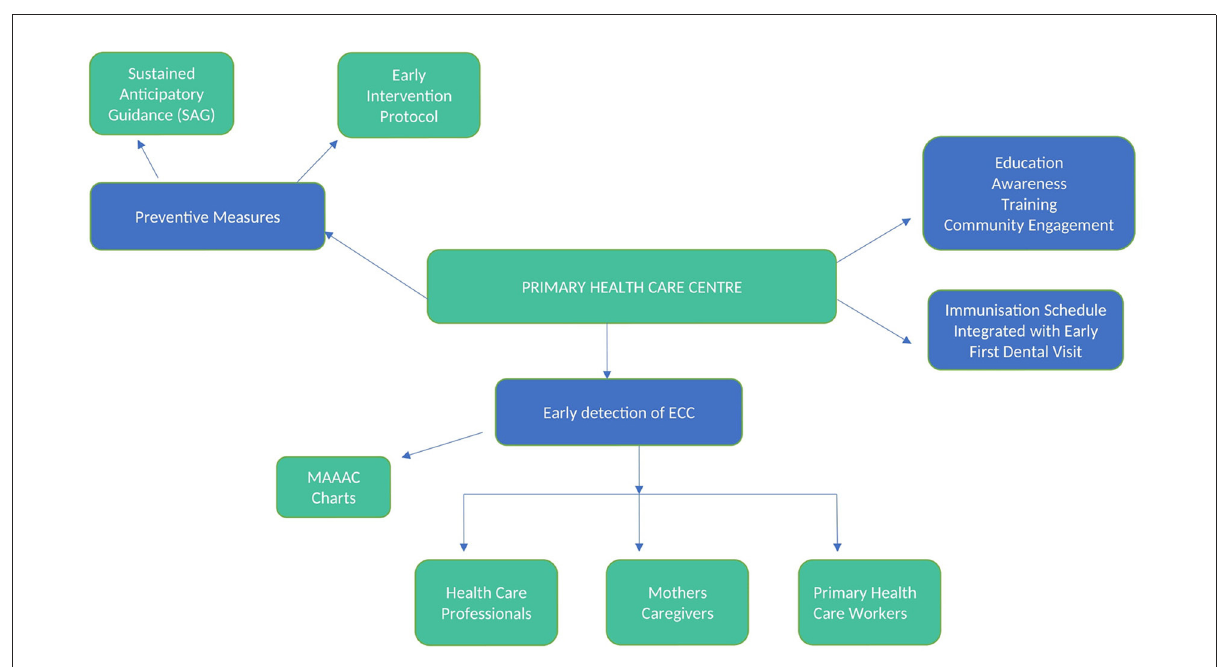
FIGURE1 Illustrates possible integration of oral health services into primary health care